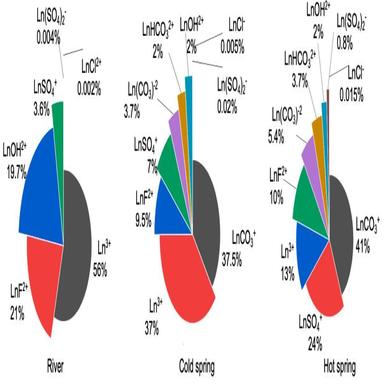
REE speciation patterns in the river, cold spring, and hot spring water samples. Ln3+ or free ions and Ln complexations (LnF2+, LnSO4 +, LnCO3 +, and LnCO3 2− ) are typical components in near-surface groundwater and intermediate–deep groundwater, respectively.